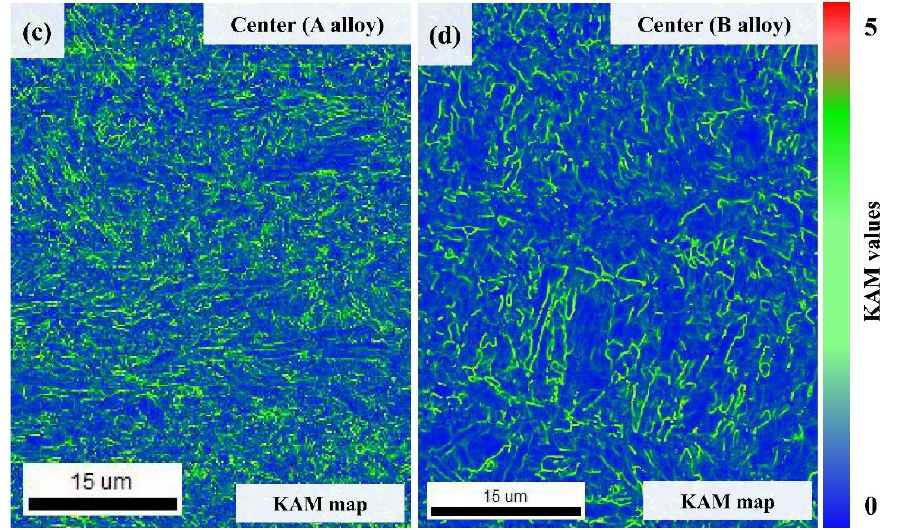
Figure 6. KAM maps of the initial microstructures of near surface regions of directly quenched steels ( a ) alloy A, ( b ) alloy B, and center region; ( c ) alloy A and ( d ) alloy B.